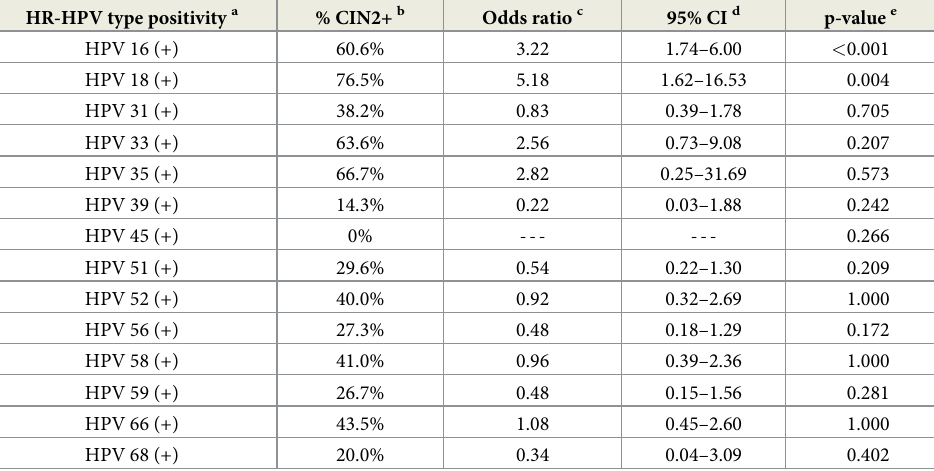
Table 3. Odds ratio for CIN2+ histological diagnosis for each HR-HPV genotype. HR-HPV type positivity a % CIN2+ b